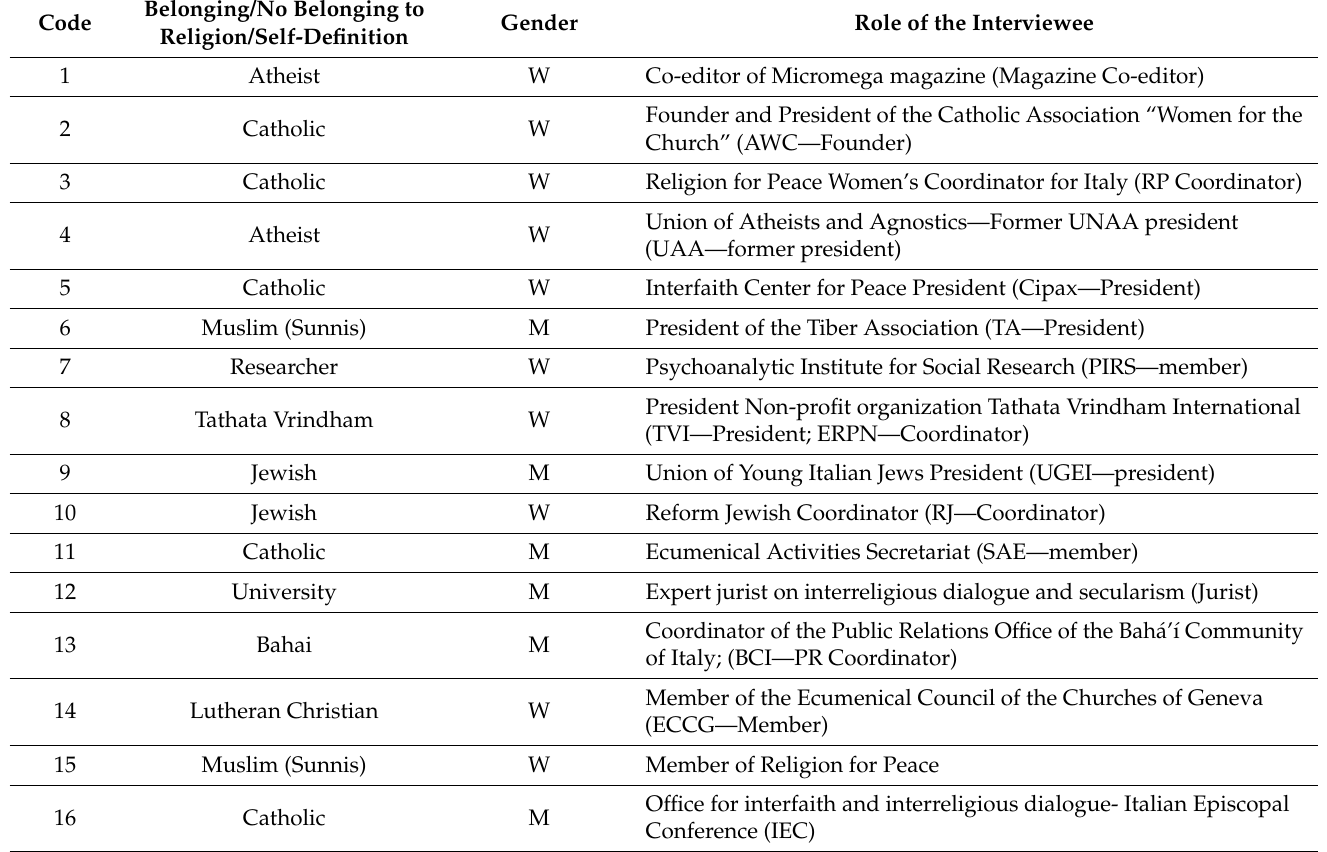
Table 1. Respondents, religious affiliation and their